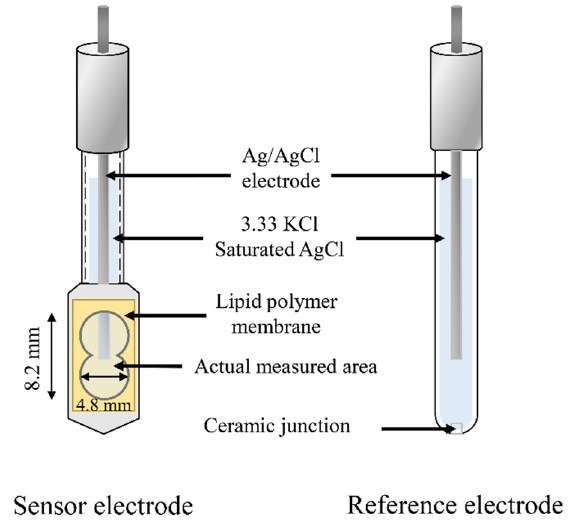
Figure 2. Constructions of taste sensor electrodes.